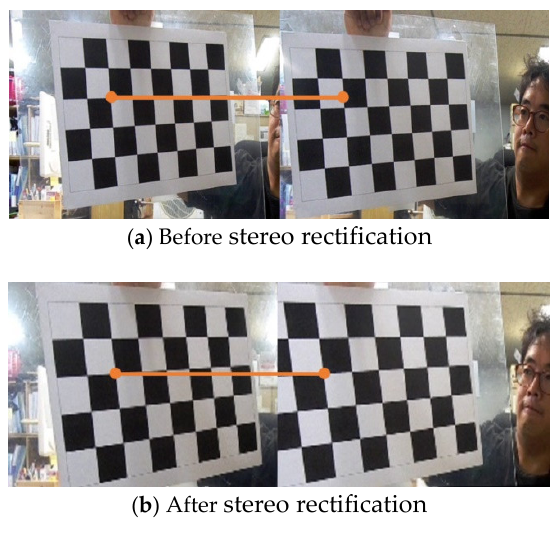
Figure 5. Stereo rectification. Figure 5. Stereo